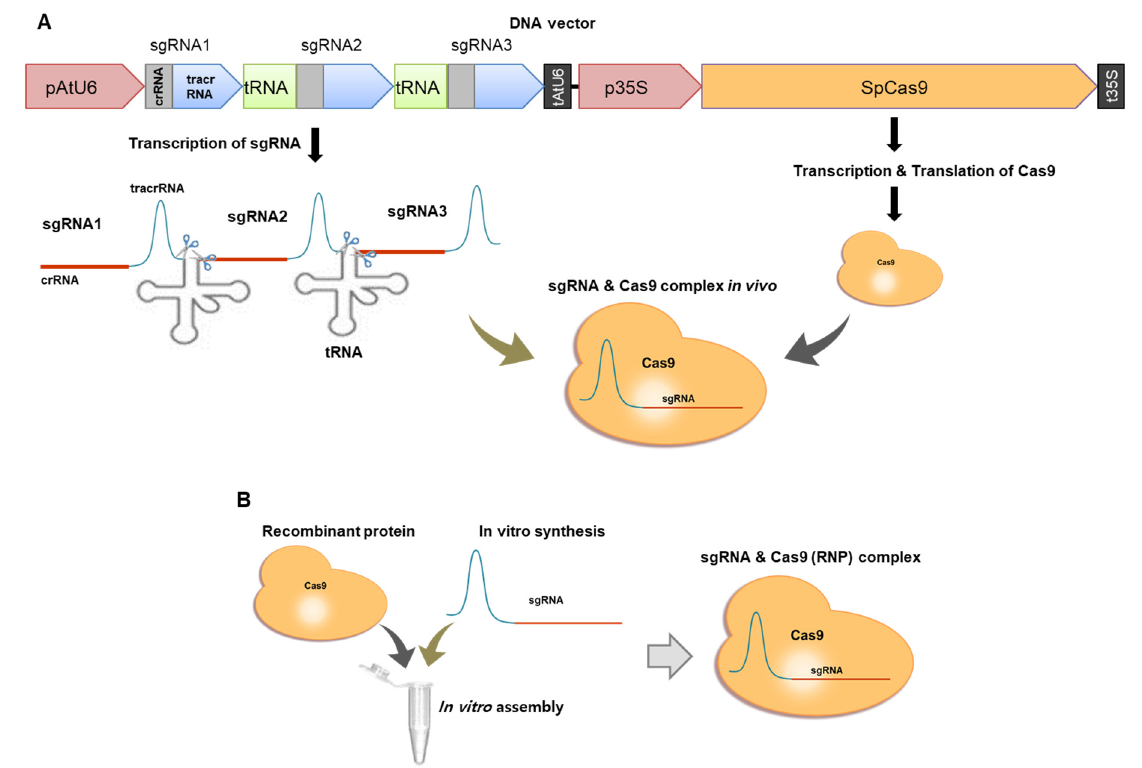
Figure 2. Schematic diagram of the preparation of ribonucleoprotein (RNP) complexes for genome editing. ( A ) Transcription and translation of sgRNAs and CRISPR associated protein 9 (Cas9) protein from the DNA vector. The sgRNAs and Cas9 protein will be assembled in vivo. ( B ) In vitro assembly of an RNP complex.